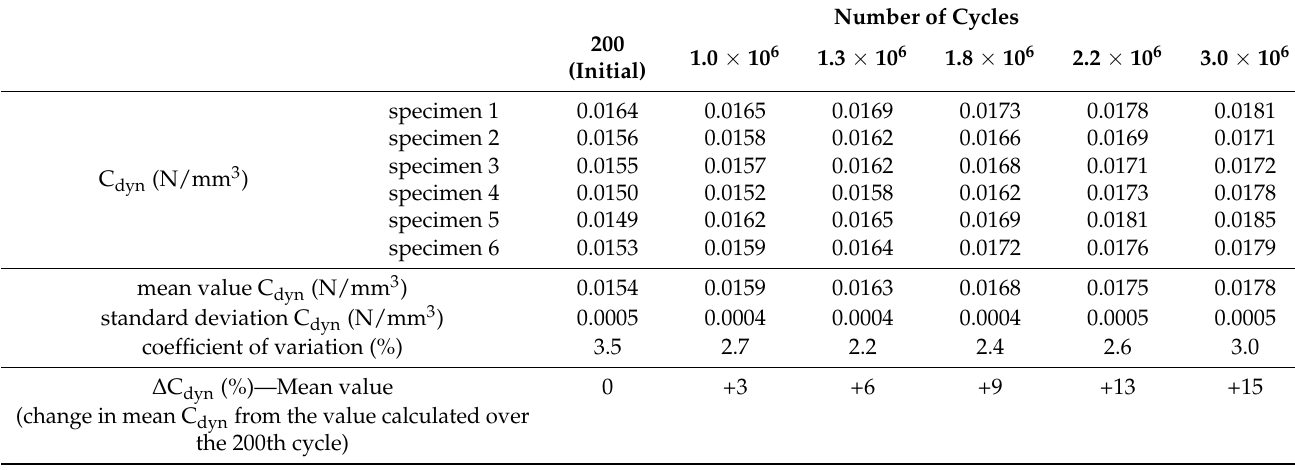
Figure 6. Experimental curves (specimen 2) showing the effect of the number of load cycles on the dynamic mechanical response (C dyn ), cyclic hardening and dynamic creep of Mat B. Table 5. Experimental results of the dynamic bedding modulus C dyn as a function of the number of load cycles for Mat A.